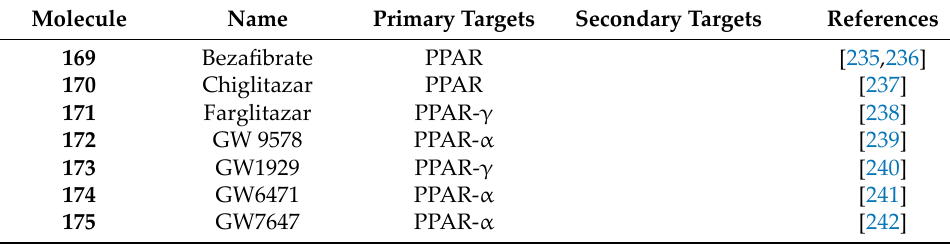
Figure 21 . 2-Phenethylamine PPAR medicinal chemistry leads. Figure 21. 2‑Phenethylamine PPAR medicinal chemistry leads. Table 8. PPAR medicinal chemistry